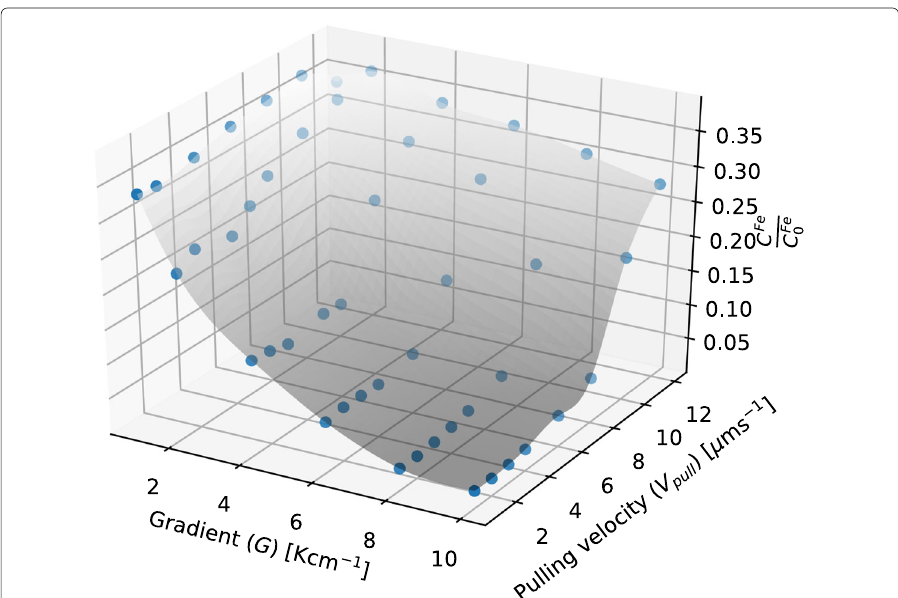
Fig. 10 Averaged Fe-concentration within the solidified material in the first 400 s of growth as a function of temperature gradient G and pulling velocity V pull